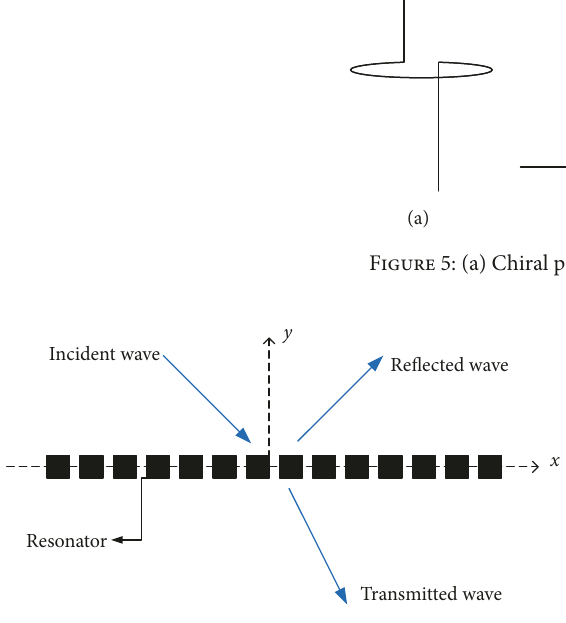
Figure 6: A metasheet (metafilm) consisting of arbitrarily shaped resonators periodically arranged in the 𝑥 - 𝑧 plane